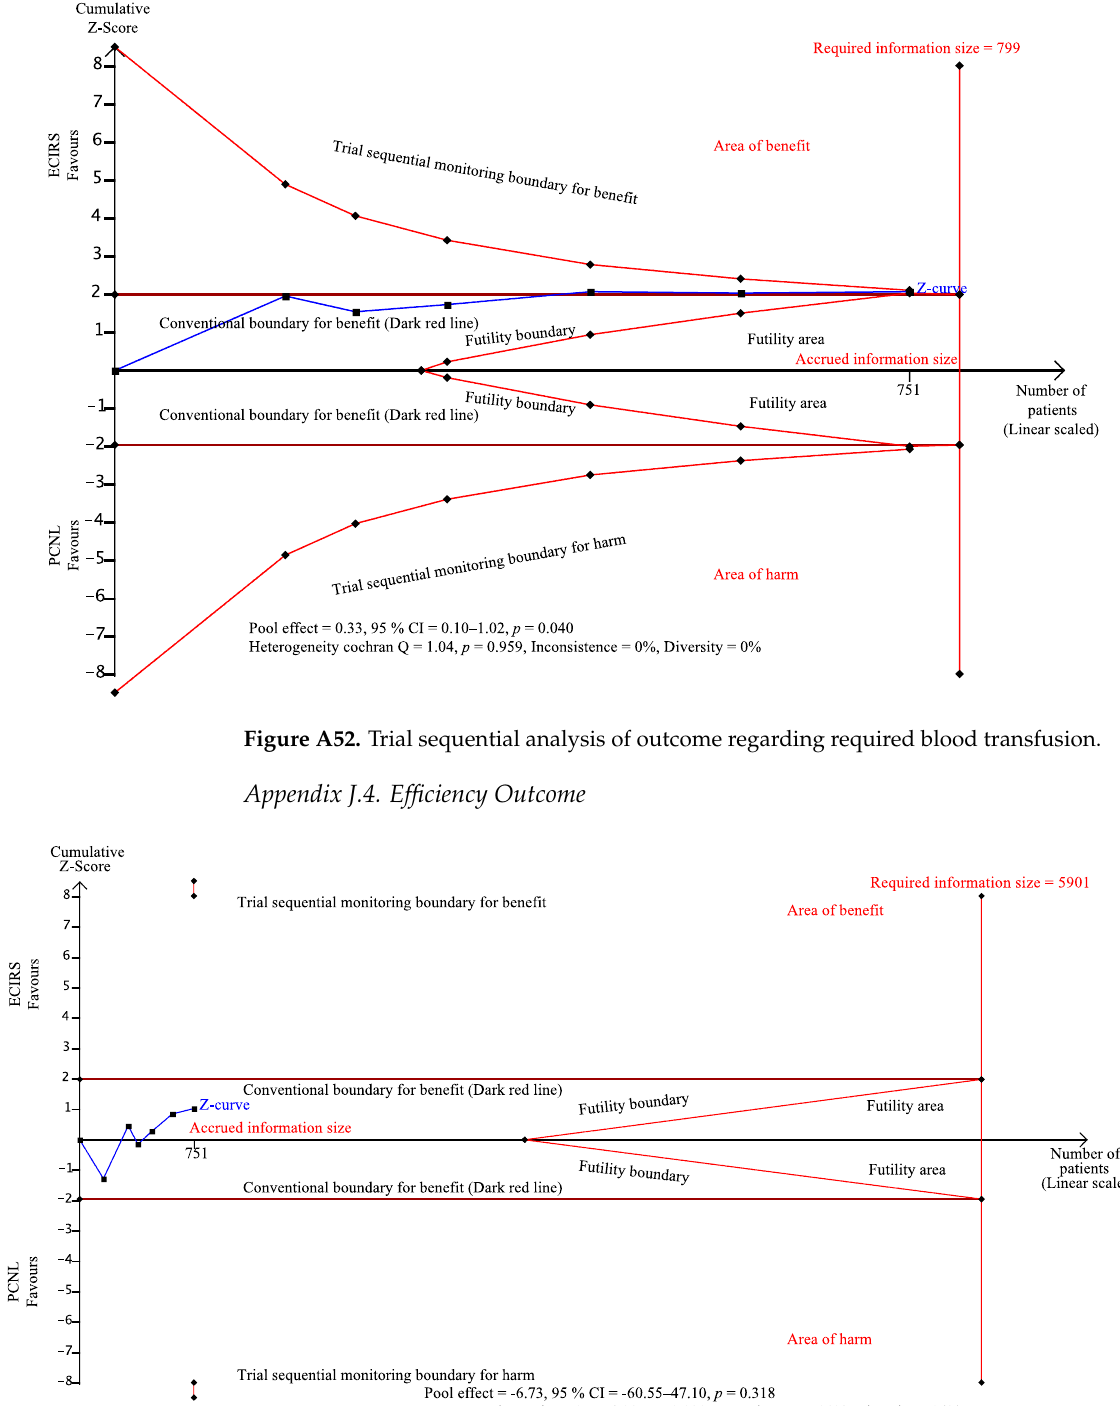
Figure A51. Comparison-adjusted funnel plot in outcome for hemoglobin drop.